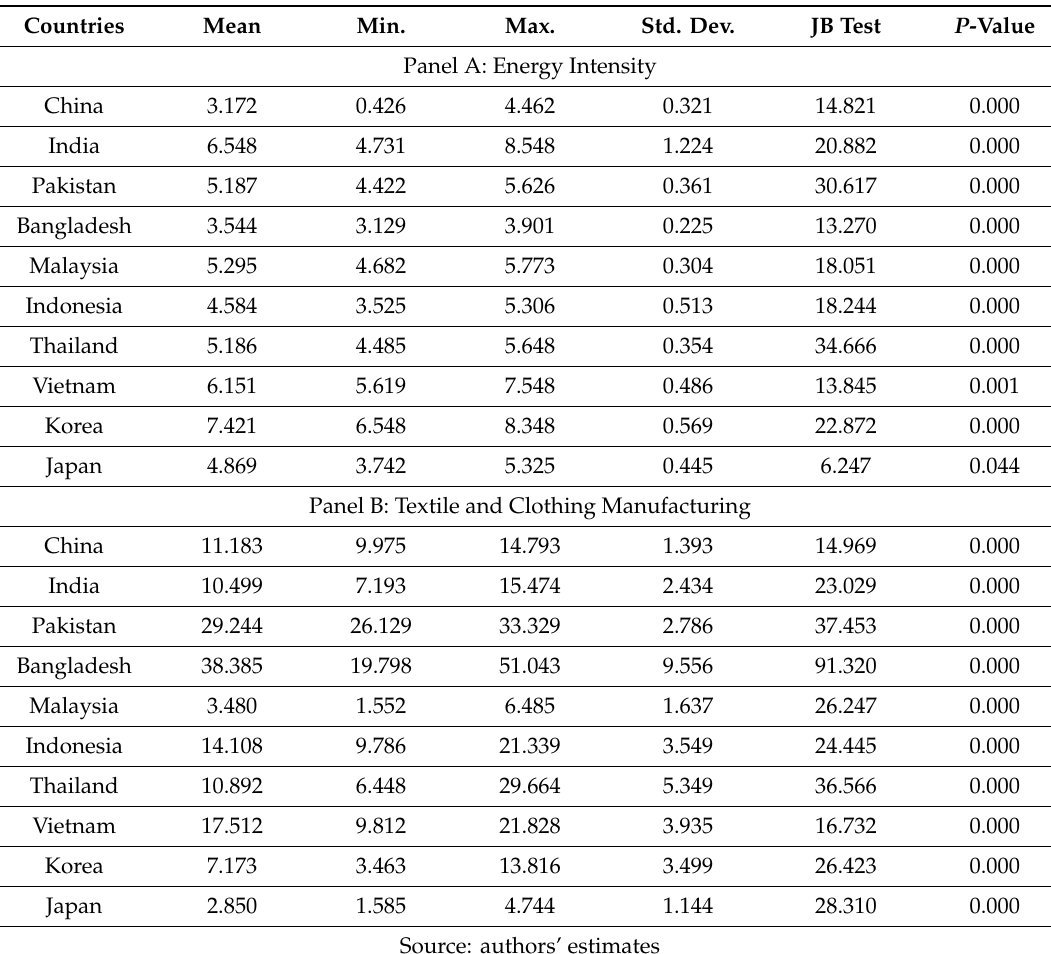
Table 1. Results of descriptive